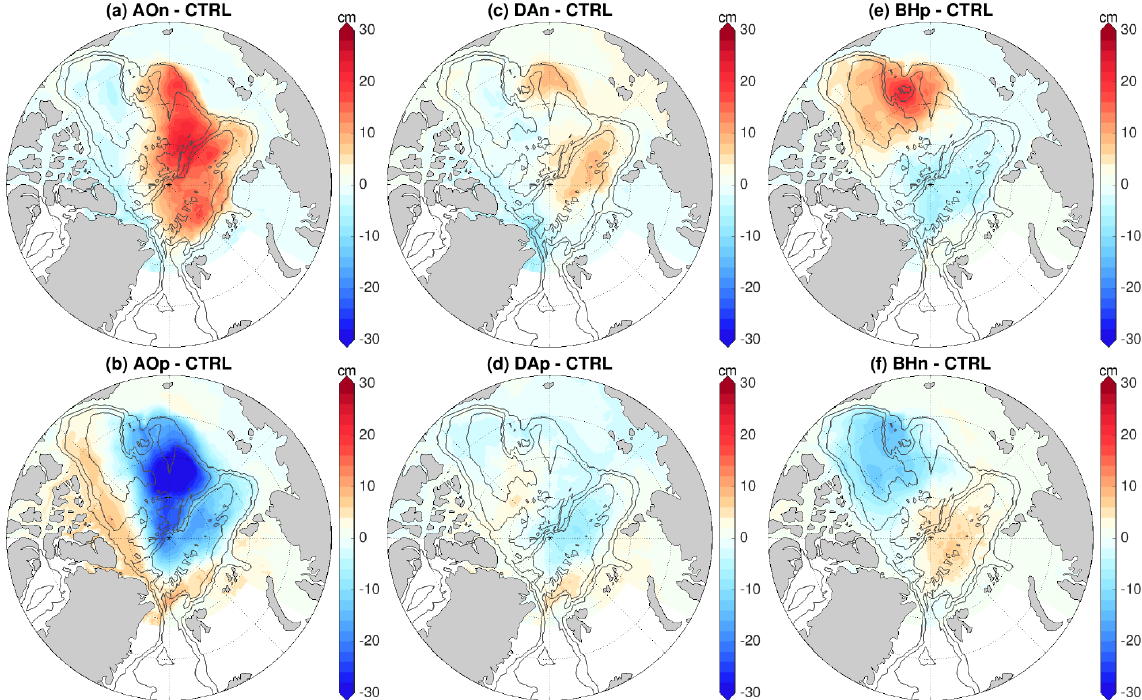
Figure 3. Anomaly of halosteric height (cm) relative to the control run averaged over the 4 model years of the sensitivity simulations in which wind perturbations were switched off: experiments with an initial ocean spun up with the (a) negative phase of Arctic Oscillation (AO) forcing, (b) positive phase of AO forcing, (c) negative phase of Dipole Anomaly (DA) forcing, (d) positive phase of DA forcing, (e) positive phase of Beaufort High (BH) forcing and (f) negative phase of BH forcing. The halosteric height is referenced to 400m depth or the ocean bottom if it is shallower than 400m. As the wind perturbations were switched off in the simulations, the anomalies indicate the ocean memory of the wind perturbations applied beforehand. The gray contour lines indicate the 500, 2000 and 3500m